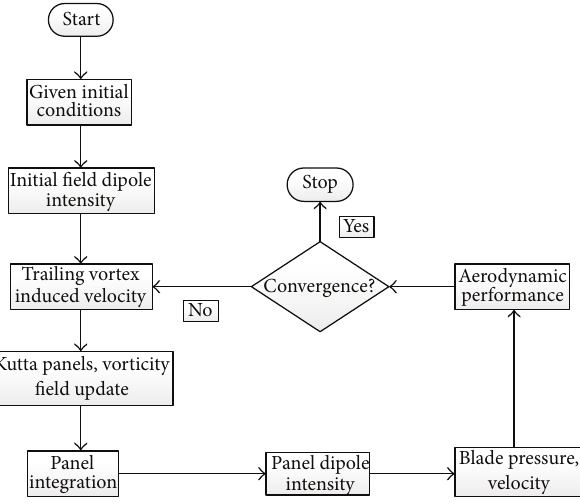
Figure 3: Flow diagram of HPVP